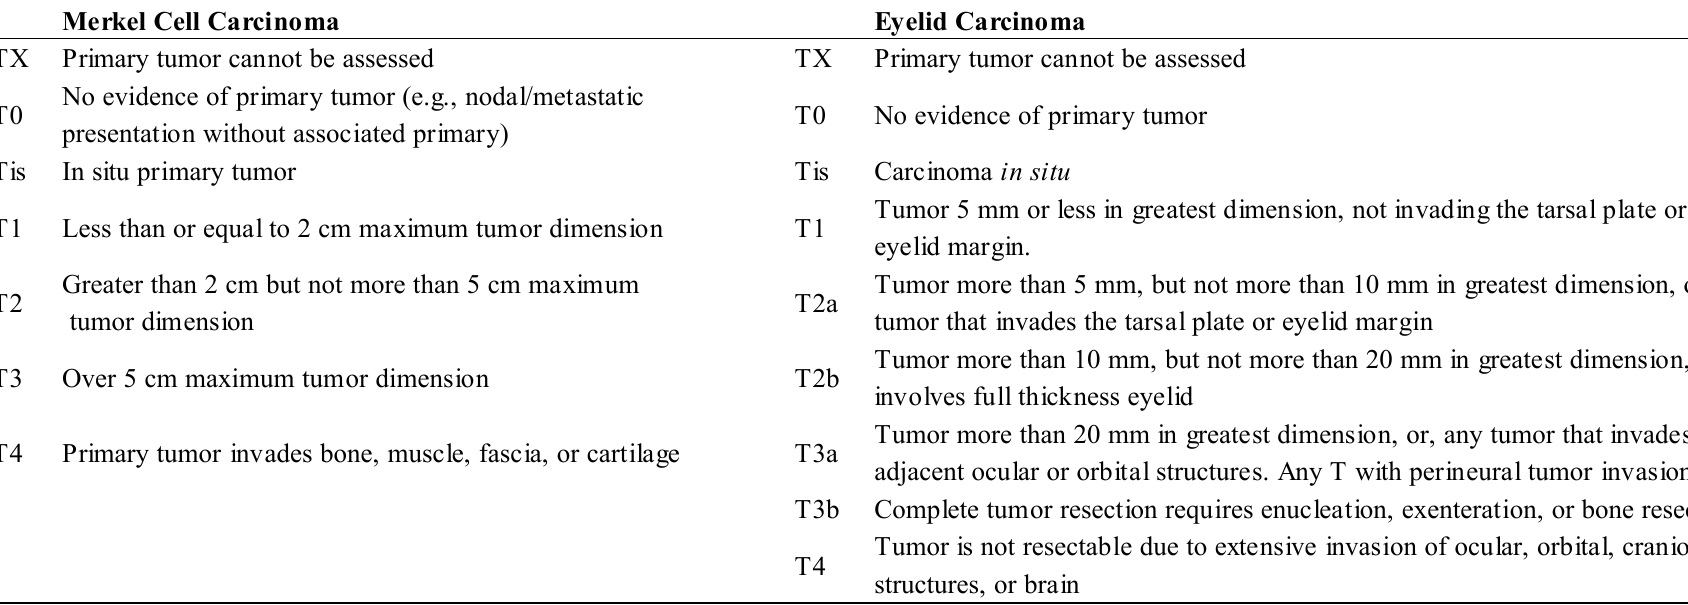
Table 1. Comparison of American Joint Committee on Cancer, 7th edition, T Categories for Eyelid Carcinoma and Merkel Cell